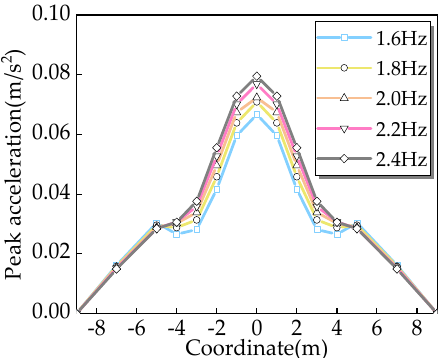
-8 -6 -4 -2 Figure 11. Effect of load frequency on peak acceleration response. Figure 11. Effect of load frequency on peak acceleration response. Figure 11. Effect of load frequency on peak acceleration